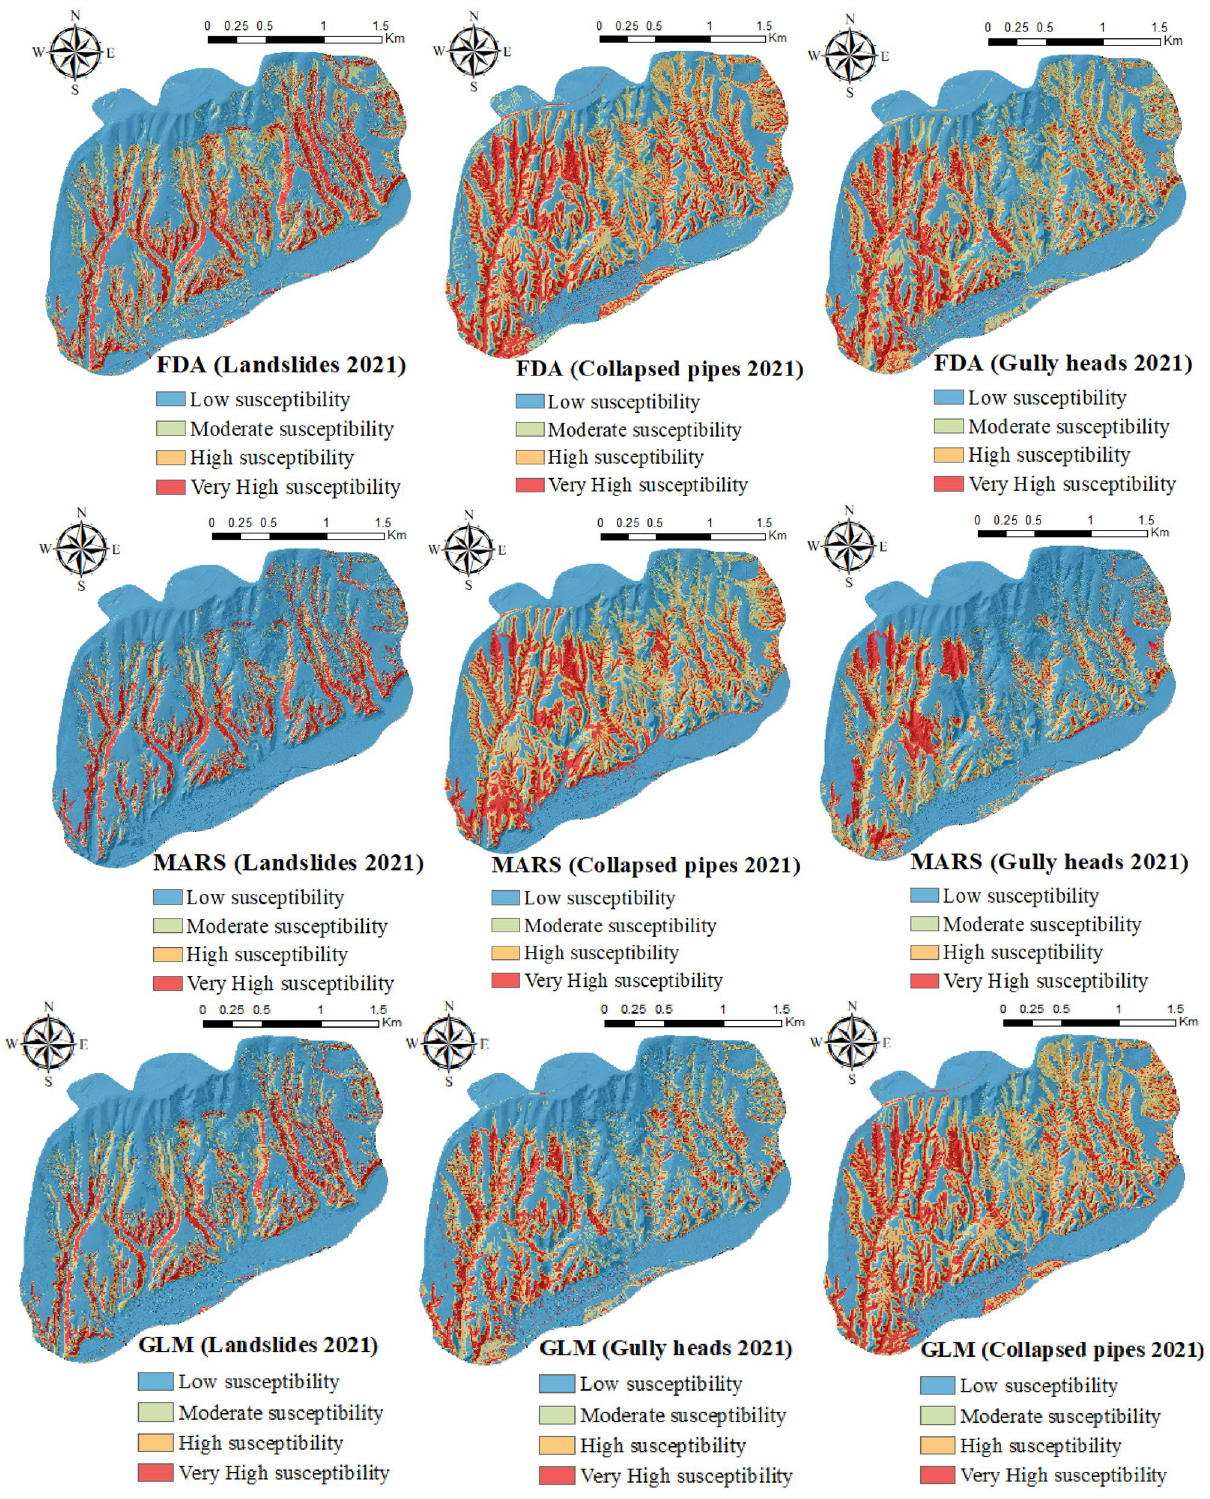
Figure 2. The susceptibility maps of three natural hazards produced using ArcGIS 10.3.1 software (https:// www. esri. com) in